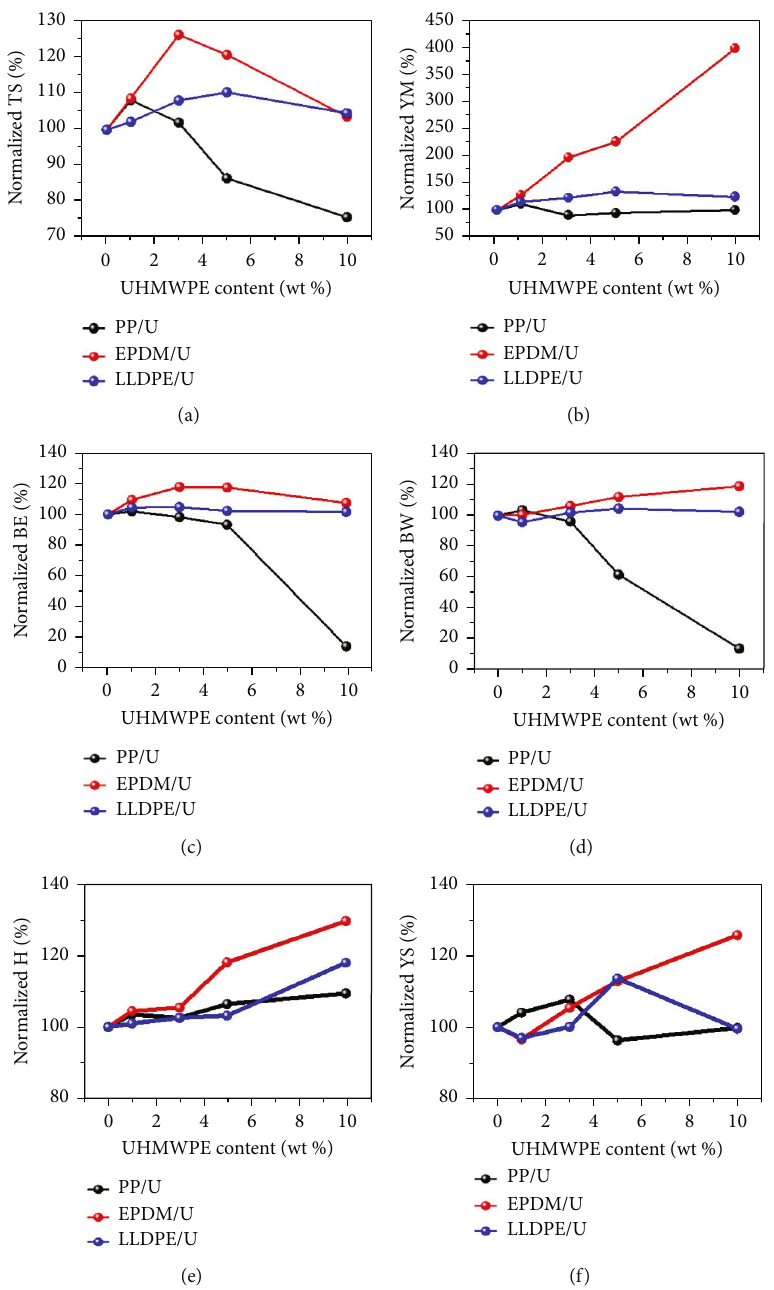
Figure 11: Normalized diagram of mechanical properties: (a) tensile strength (TS), (b) Young ’ s modulus (YM), (c) breaking elongation (BE), (d) breaking work (BW), (e) hardness (H), and (f) yield stress